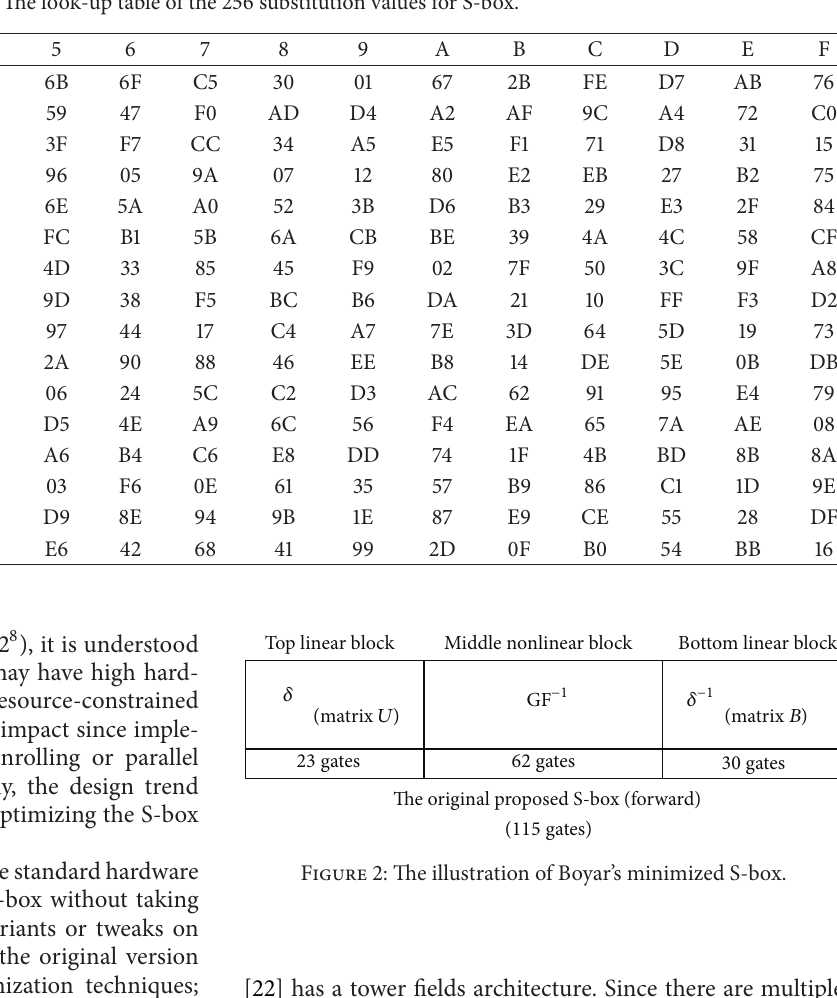
Table 1: The look-up table of the 256 substitution values for S-box.